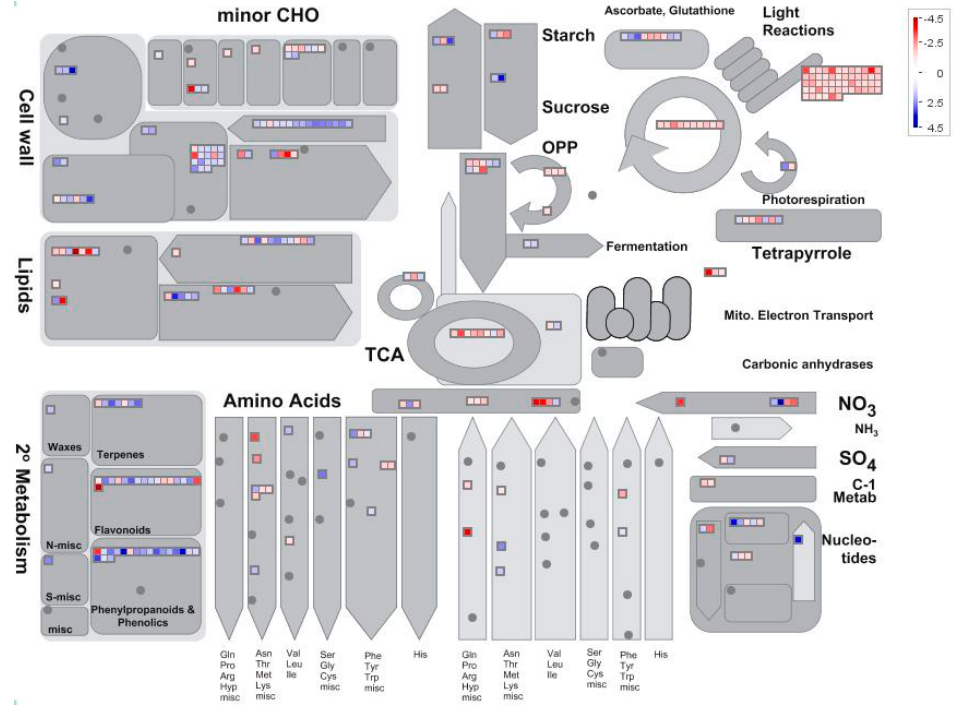
Figure 4. The distribution of different gene expressions involved in metabolism in maize leaf (low nitrogen versus high nitrogen). High nitrogen: 4 mM Ca(NO 3 ) 2 ; Low nitrogen: 40 µM Ca(NO 3 ) 2 .